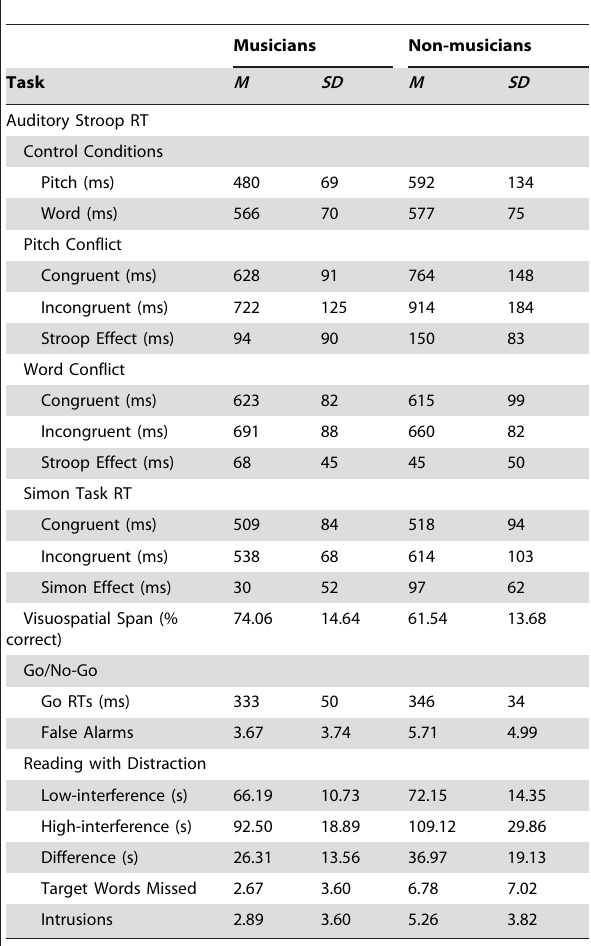
Table 2. Mean scores and standard deviations for musicians and